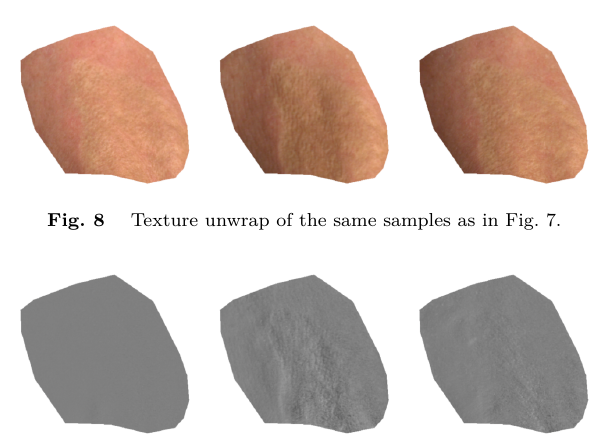
Fig. 9 Shifted differences of the unwrapped samples in Fig. 7 and the reference region.